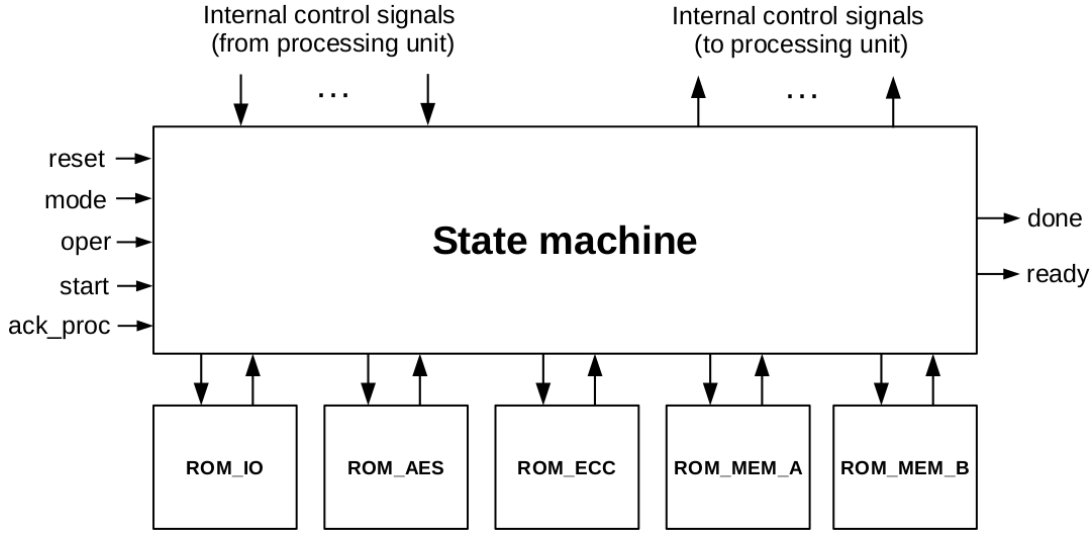
Figure 16. Block diagram of ECC163AES128 control unit.